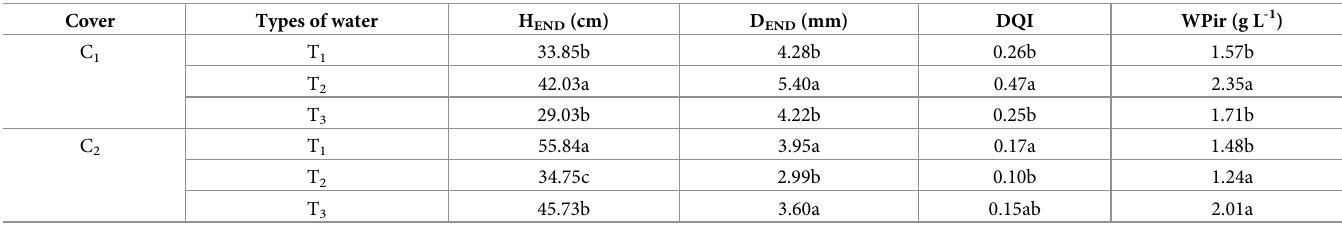
Table 3. Morphological attributes of D . nigra seedlings under full sun (C 1 ) and under cover with 50% shading (C 2 ) at 122 days after emergence (DAE).